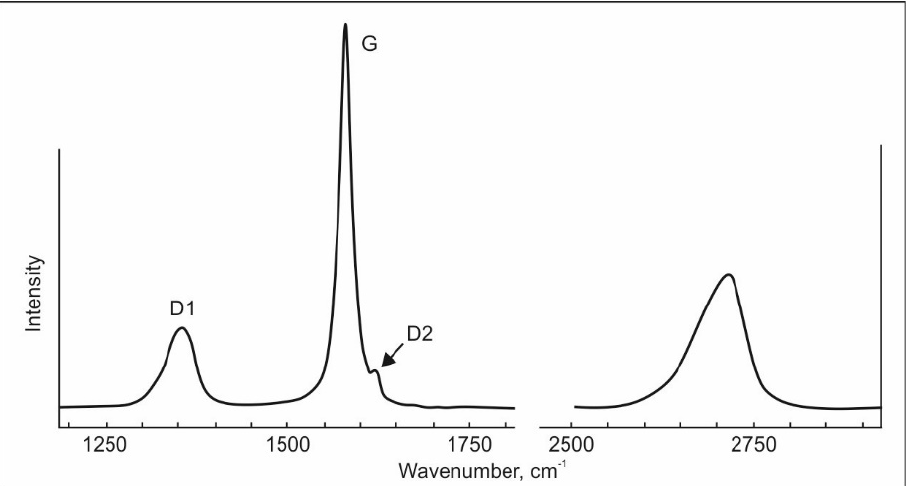
Figure 7. An example Raman spectrum of CM from the sample oc-24 from Olympiada deposit, illustrating four distinct peaks.